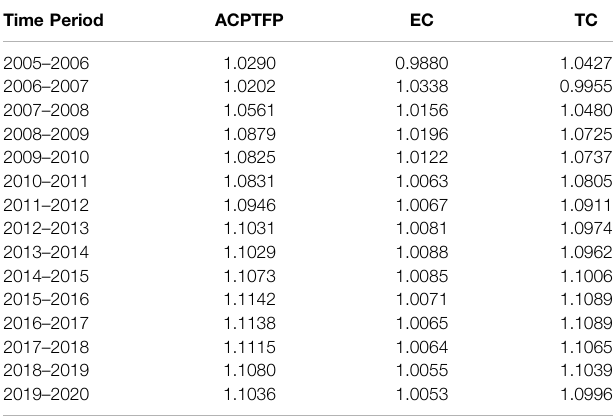
TABLE 2 | Agricultural carbon emission performance, 2005 – 2020.